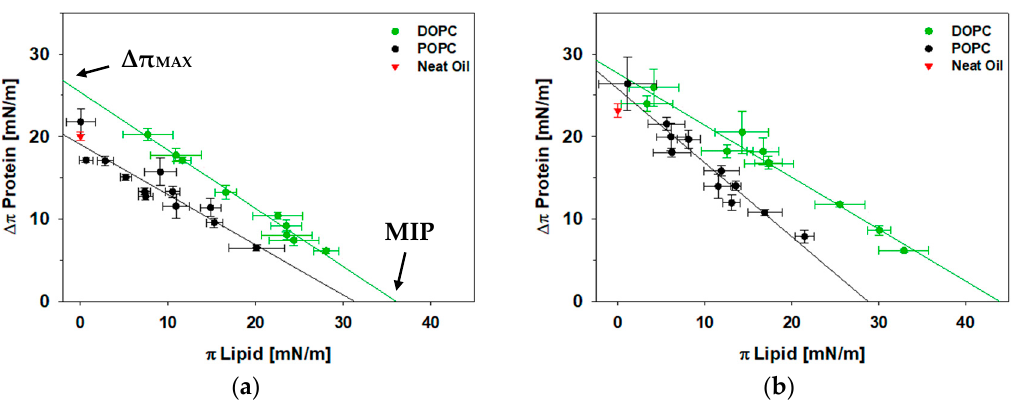
Figure 4. ( a ) Insertion isotherms of the C-terminus of perilipin 3 (PLN3D) as a function of lipid packing for 1,2-dioleoyl-sn-glycero-3-phosphocholine (DOPC, green) and POPC (black) monolayers; ( b ) Insertion pressure of full-length perilipin 3 (PLN3A) as a function of lipid packing for DOPC (green) and POPC (black) monolayers. Red triangles correspond to the protein surface pressure without lipid monolayer, 20.1 ± 0.5 mN/m and 23.1 ± 0.8 mN/m, for the C-terminus of perilipin 3 and the full-length protein respectively. Error bars are the standard deviation of surface pressure values after drop expansion/contraction ( π Lipid ) and after addition of protein ( Δπ Protein ).